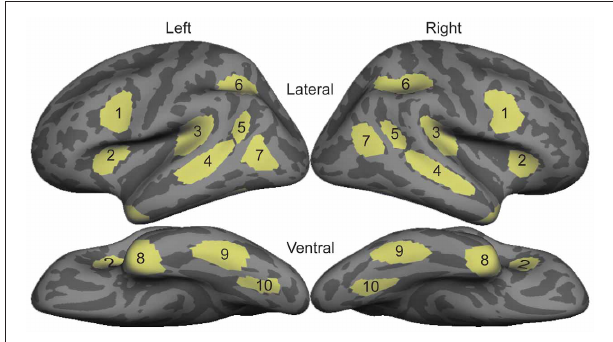
FIGURE 1 | Diagram of bilateral ROI locations. These ROIs were selected based on an independent data set that compared sign in native deaf individuals to speech in hearing individuals (Leonard et al., 2012). 1, Inferior Prefrontal; 2, Anterior Insula; 3, Planum Temporale; 4, Superior Temporal Sulcus; 5, Posterior STS; 6, Intraparietal Sulcus; 7, Lateral Occipito-temporal cortex; 8, Temporal Pole; 9, Inferior Temporal; 10, Ventral Occipito-temporal cortex.